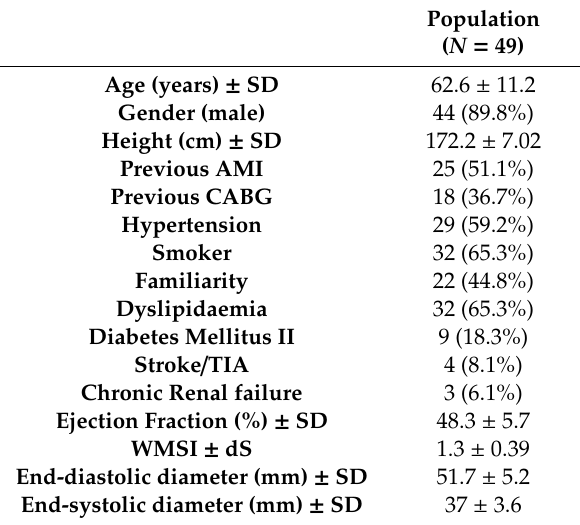
Table 1. Baseline clinical and echocardiographic features of the study